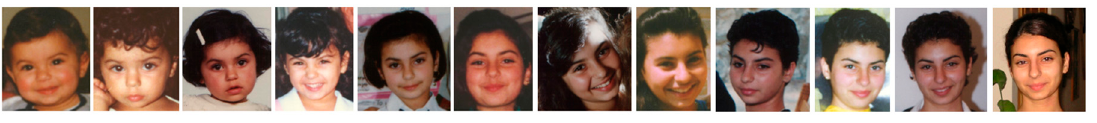
Figure 1. A person’s picture with a certain time span.